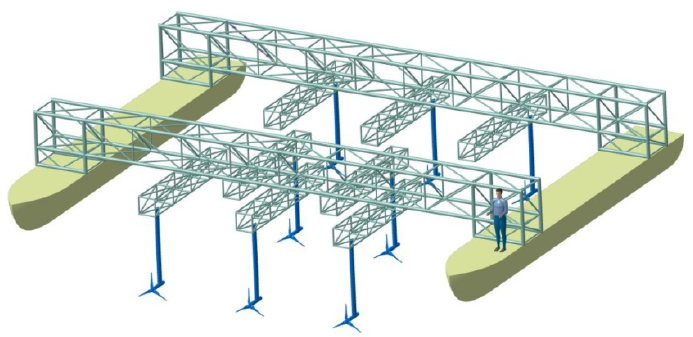
Figure 1. 3D model of the testing